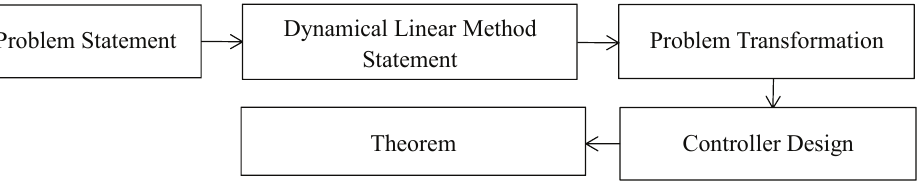
Figure 1. The flowchart of solving the bipartite containment problem of